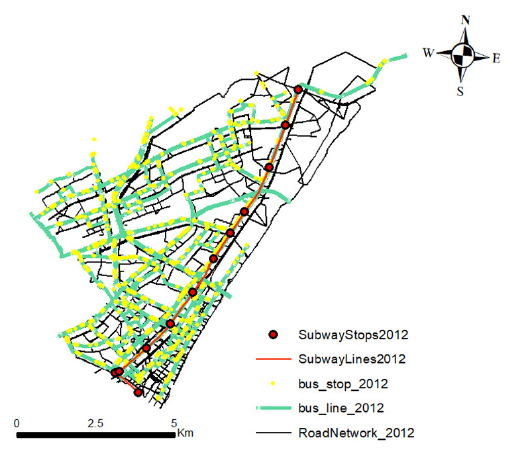
Table 2. Total space quantity (m 2 ) and average space price (Yuan/m 2 ).